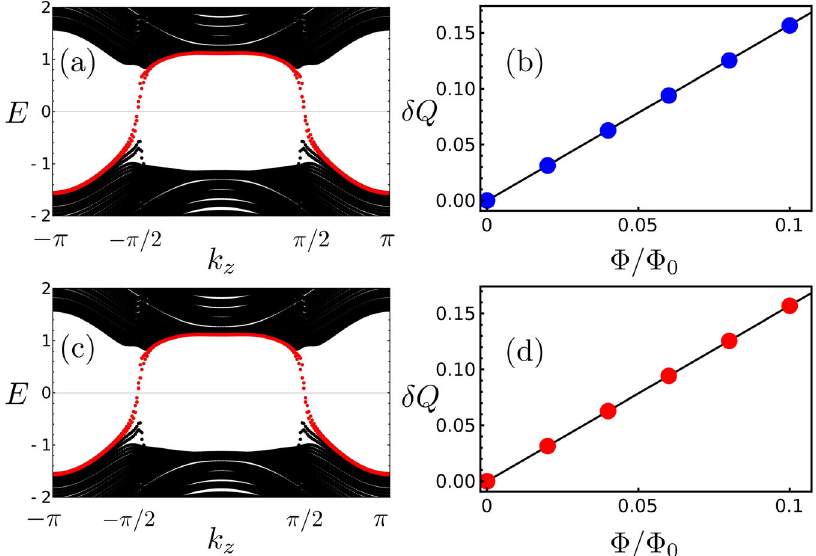
Fig. 7 Chiral zeroth Landau level and chiral anomaly in a projected Weyl semimetal (PWSM). The underlying 1D chain (hosting projected Chern or normal insulators) is embedded in a parent 2D square lattice at a rational [( a ) and ( b )] and an irrational [( c ) and ( d )] slopes. a Energy spectra of H PTB ( k z , B ) [Eq. (1)] in the presence of a uniform magnetic fi eld B ¼ B ^ z with periodic (open) boundary condition along x ( y ) direction. Chiral zeroth Landau level (red dots) crosses the zero energy at k z = ± π /2, locations of the Weyl nodes [Fig. 6]. b Accumulated charge ( δ Q ) around a magnetic fl ux tube piercing a PWSM in the z direction as a function of Φ / Φ 0 , where Φ ( Φ 0 ) is the magnetic fl ux ( fl ux quantum). Within the numerical accuracy the slope of the straight line is π /2, in agreement with fi eld theoretic prediction 50,51 . c and d Are analogous to ( a ) and ( b ), respectively. The linear dimension of the system L = 32 in the x and y directions, and we set x u = 8 and x d = 6 [Fig.